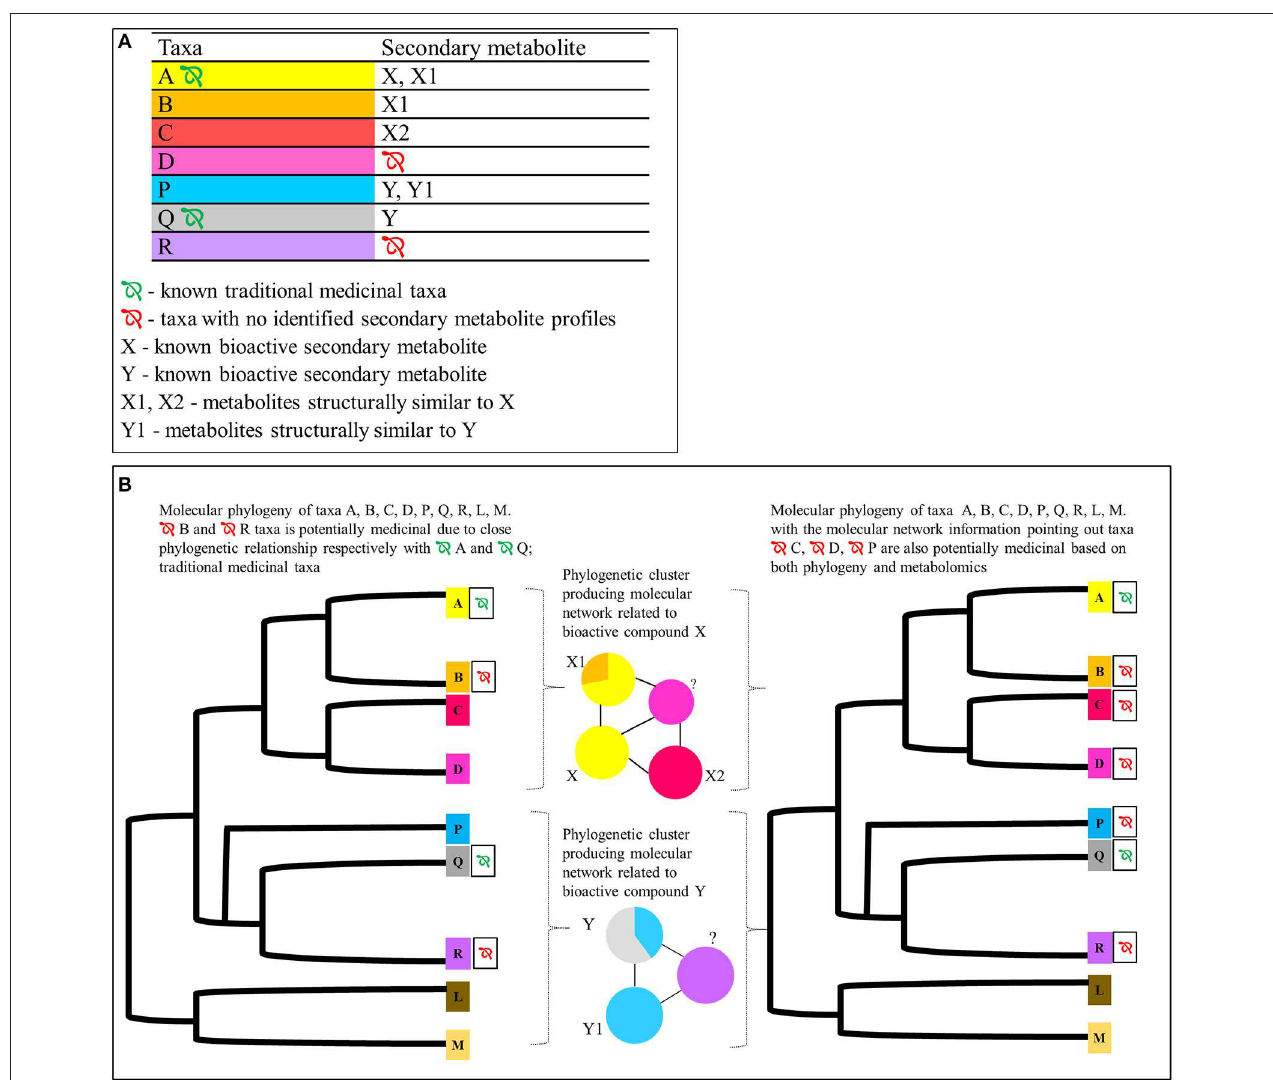
FIGURE 3 | Proposed integrated approach for identifying potentially medicinal plant taxa using metabolomics profiles of species A, B, C, and D (phylogenetically closely related species belonging to same operational taxonomic unit/family) and species P, Q, and R (likewise but from a different operational taxonomic unit/family). (A) Hypothetical secondary metabolites identified using UHPLC-MSMS in respect to taxa A, B, C, D, P, and Q. Only taxa A and Q have previously known traditional medicinal uses. Taxa A and Q express the already identified bioactive metabolites X and Y, respectively. Taxon D is phylogenetically closely related to taxa A, B, and